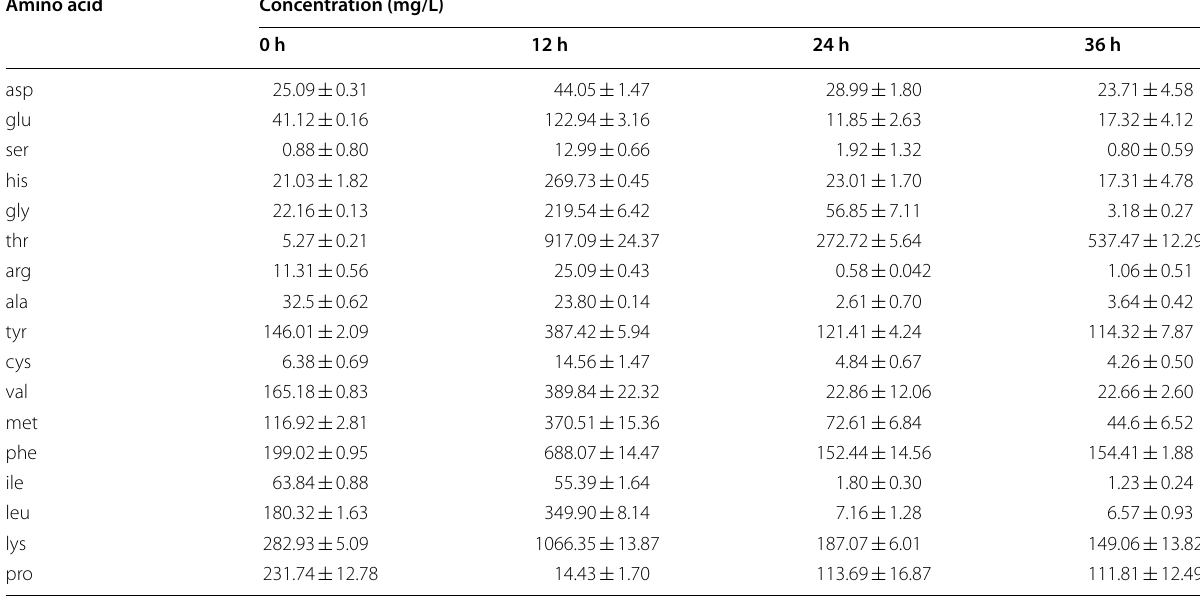
Table 2 The changes of amino acid concentration during feather degradation process by the variant T18 Amino acid